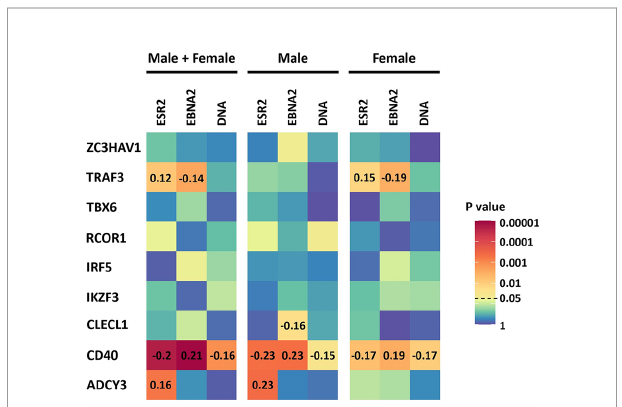
FIGURE 3 | The correlation of the expression of the 9 MS risk genes in this study with Estrogen receptor 2 (ESR2) and the EBV latency III traits EBNA2 and EBV DNA copy number (DNA) of LCLs of known donor gender. ESR2, EBNA2 and EBV DNA copy number correlation with the expression of the 9 MS risk genes in male and female LCLs combined (Left), in male LCLs (center), and in female LCLs (right). The correlations were calculated using Spearman ’ s rank correlation coef fi cient. Heatmap shows the signi fi cance of the correlations (p value). For those correlations of statistical signi fi cance (p value less than 0.05), the Spearman ’ s correlation coef fi cient value (rho) is represented with numbers in the corresponding cells. The RNA-seq based expression levels for ESR2, EBNA2 and LMP1 were obtained from the GEUVADIS study and EBV Portal for 216 male LCLs and 248 female LCLs. The estimated EBV DNA copy number and ESR2 expression level for 201 male and 232 female LCLs were used to estimate the correlation between ESR2 and EBV DNA copy